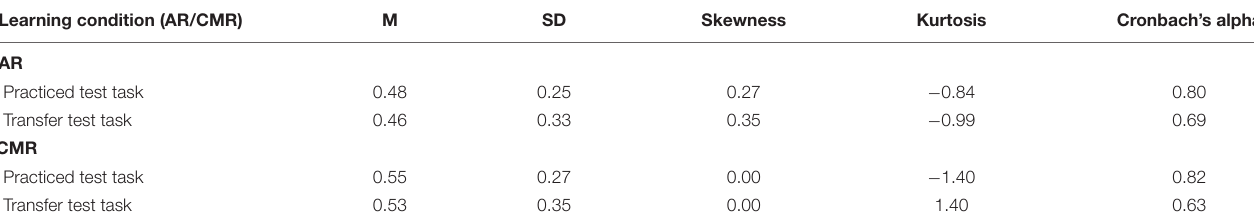
TABLE 2A | Mean proportion correct response ( M ) and standard deviations ( SD ), skewness, kurtosis and Cronbach’s alpha for the AR and CMR learning conditions, respectively. Learning condition (AR/CMR)